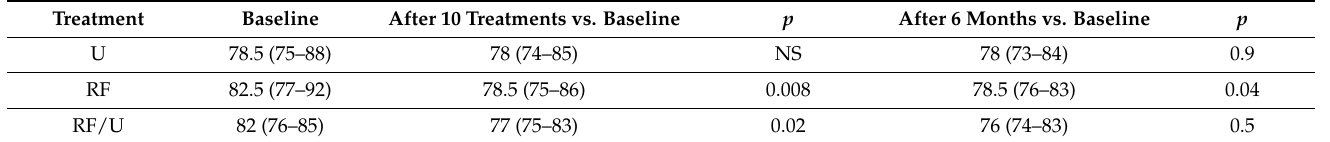
Table 5. Waist circumference of the studied women